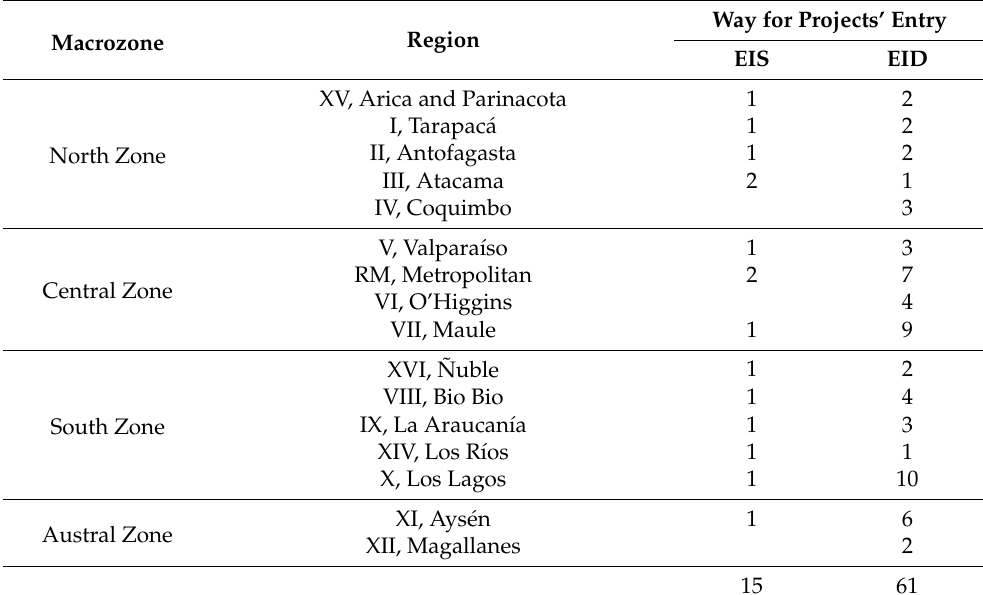
Table 2. Selected EIS and EID sanitation projects to implement the statistical analysis, catalogued by macrozone and region of Chile.